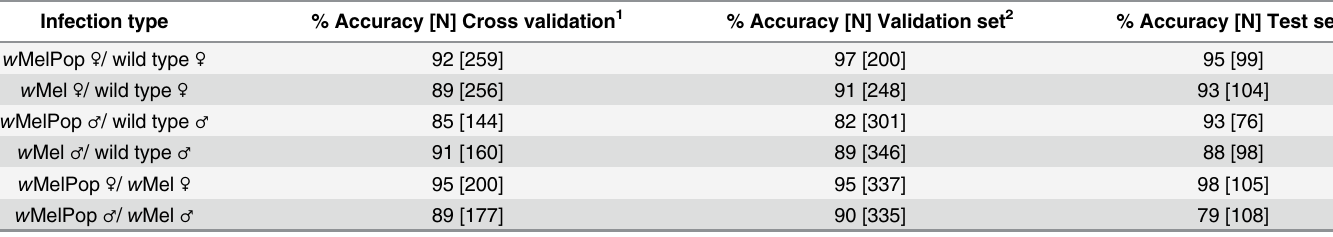
Table 1. Percentage accuracy of Wolbachia detection using cross validation and prediction analyses. Infection